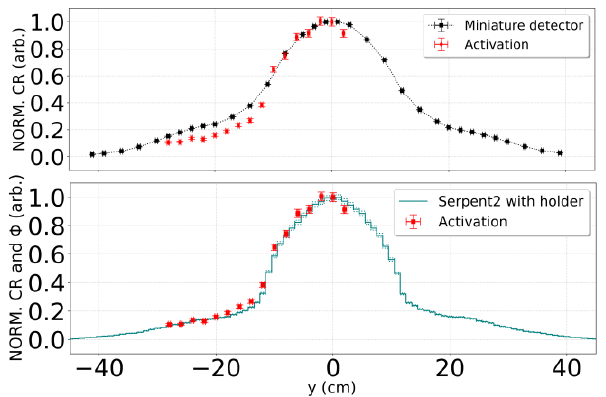
Fig. 8 - Direct comparison of the activation profile with measurements of miniature detector (top); Comparison of the activation profile with Serpent2 computed results